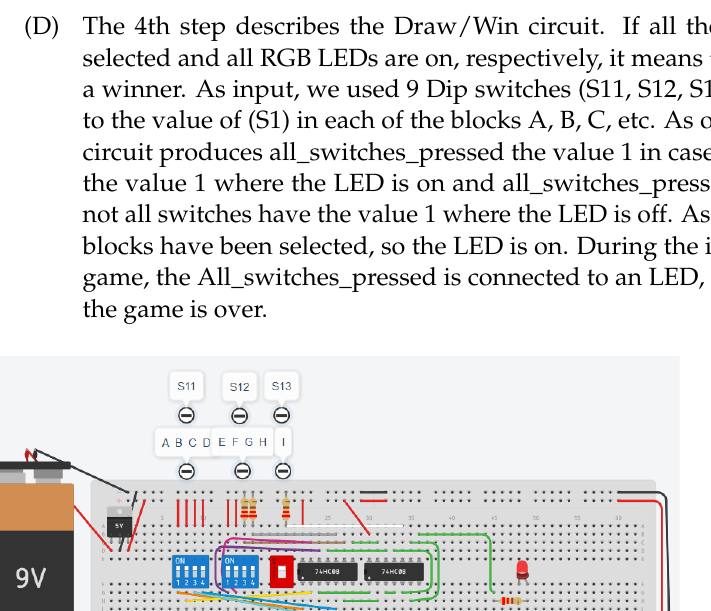
Figure 5. Winner circuit (Tinkercad).